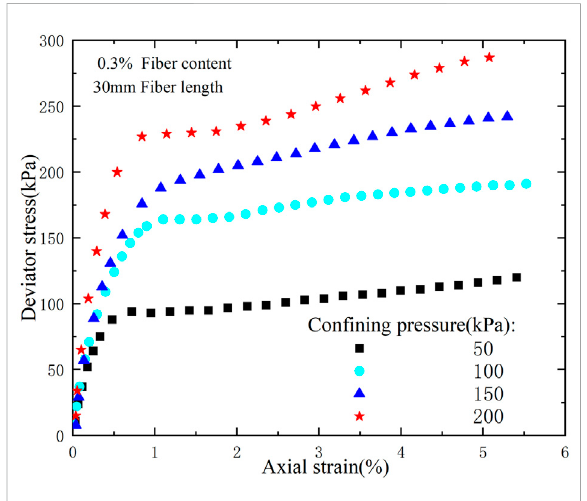
FIGURE 6 Effect of stress-strain on samples within 50 – 200 kPa of con fi ning pressure with constant fi ber length and fi ber content.